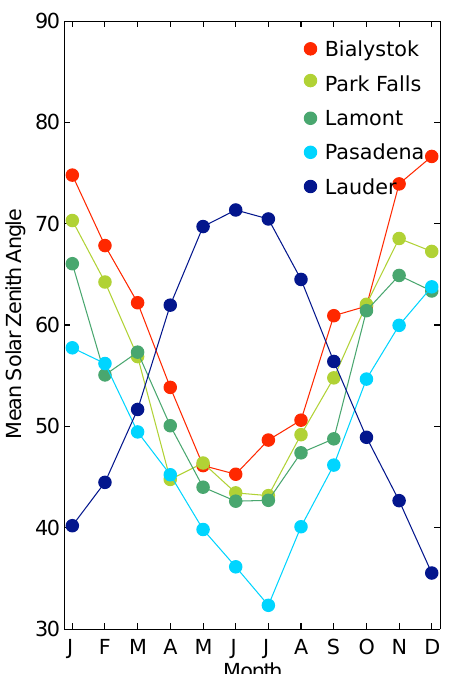
Fig. B1. Monthly mean solar zenith angles for TCCON